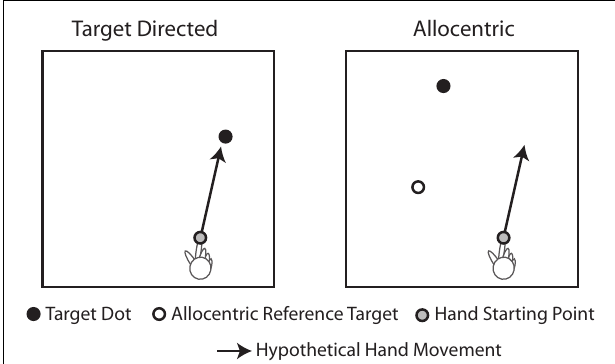
FIGURE 1 | Illustration of target-directed and allocentric movement tasks. In the target-directed task, the subject is instructed to move the finger toward the black target dot.Thus, the movement can be programmed based on the egocentric position of the target with respect to the viewer. In the allocentric task, the subject is instructed to move the finger to a location in space, the position of which with respect to the starting point of the finger matches the position of the black target dot with respect to the white reference dot (the allocentric reference target).Thus, the movement in the allocentric task cannot be programmed based on the egocentric position of the target, but instead, it has to be programmed based on the allocentric position of the target, i.e., the position of the target with respect to the allocentric reference target.